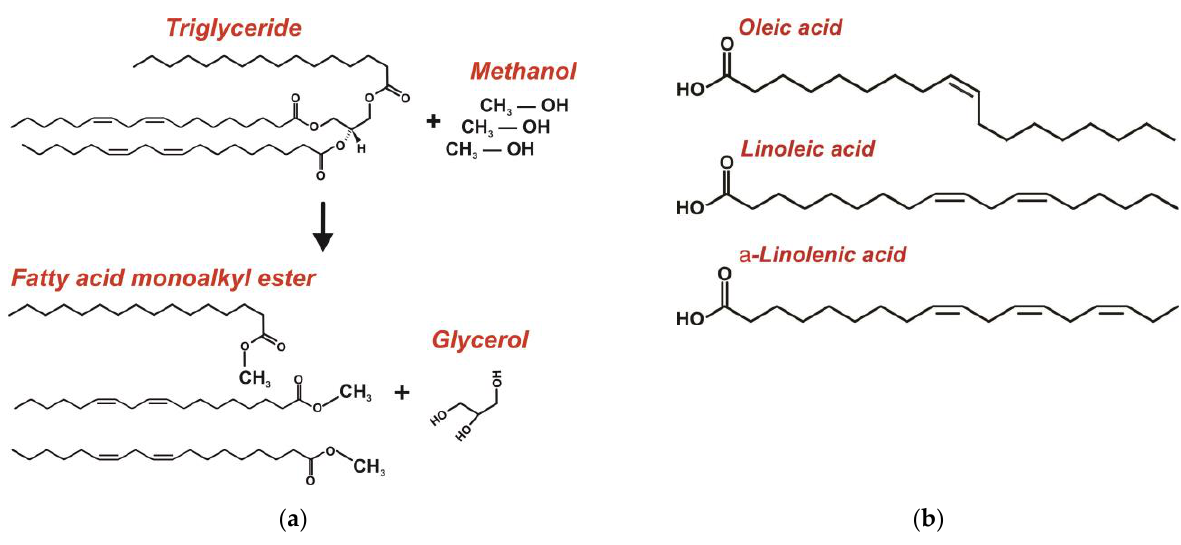
Figure 5. Biofuel sources and production: ( a ) Esterification reaction; ( b ) Some types of fatty acids. Adapted from [82].